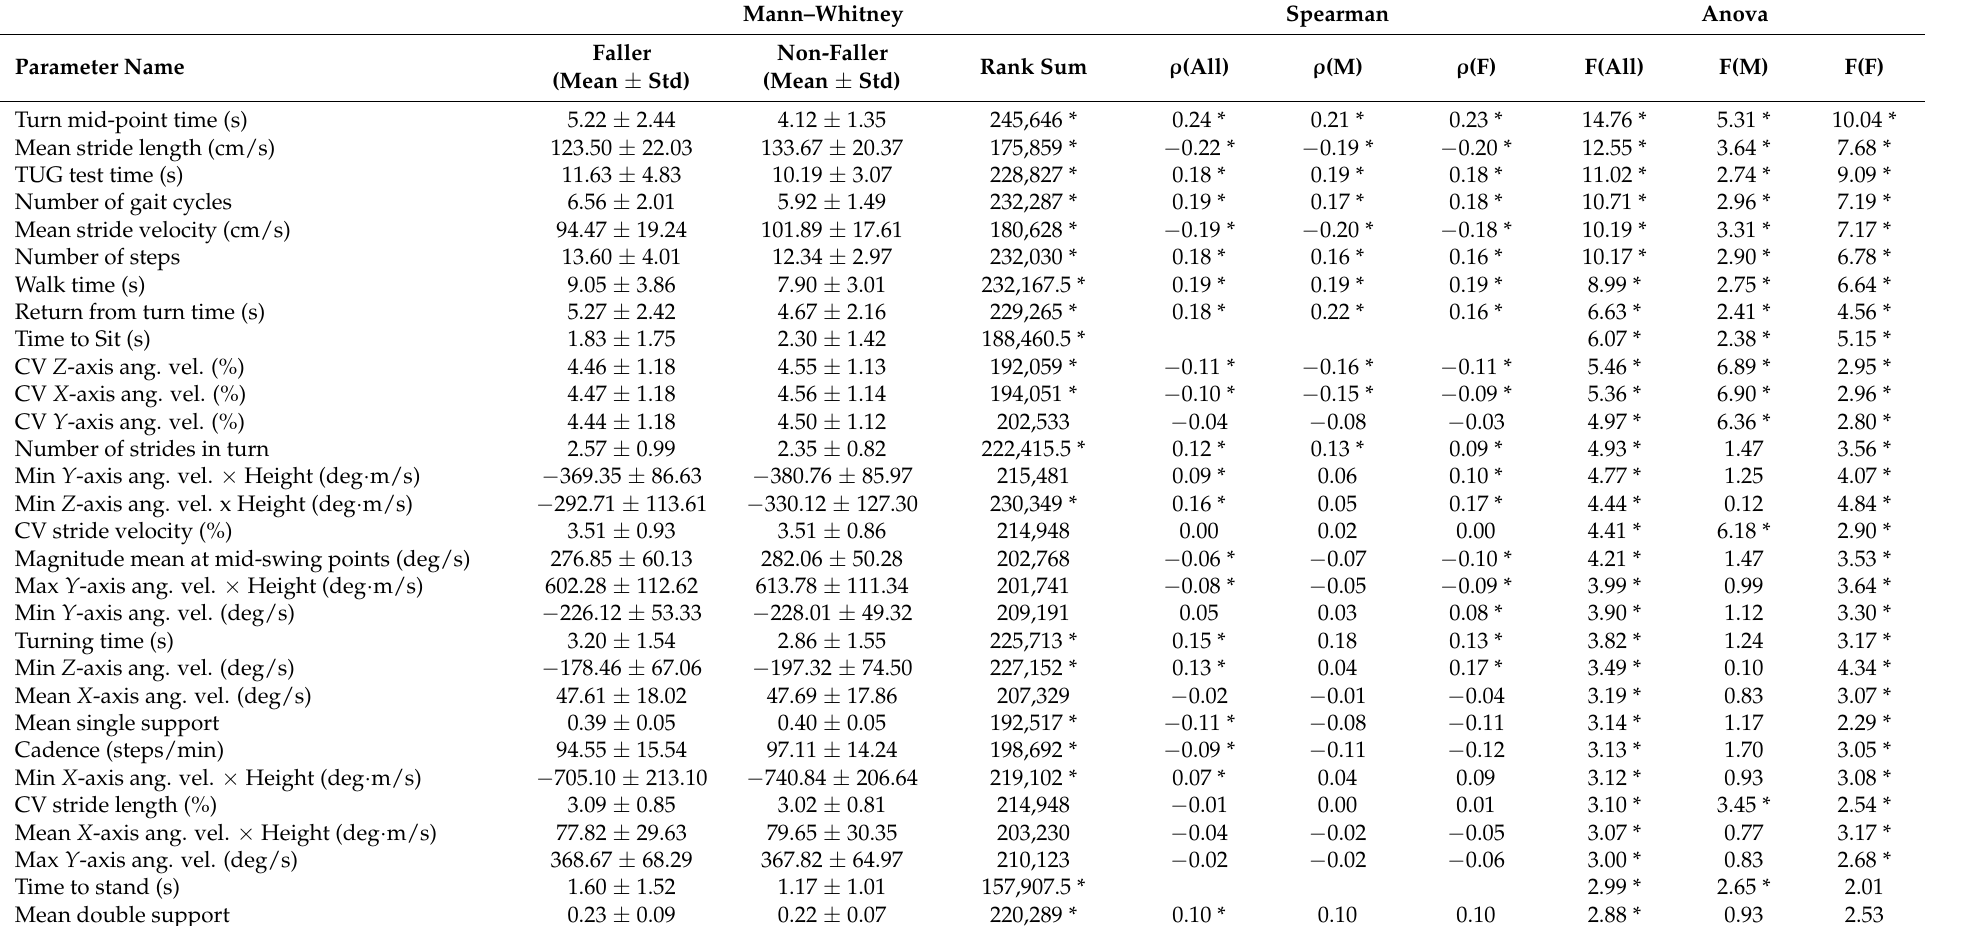
Table A2. Statistical analysis of QTUG parameters with falls counts for TD dataset. M and F refer to population stratified by gender (male and female). U refers to Mann–Whitney rank sum statistic, ρ refers to Spearman’s correlation coefficient, while F refers to F-score from 1-way Anova test. Statistically significant differences ( p < 0.05) are indicated by